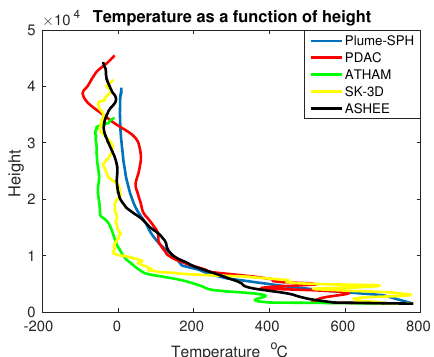
Figure 11. Temperature as a function of